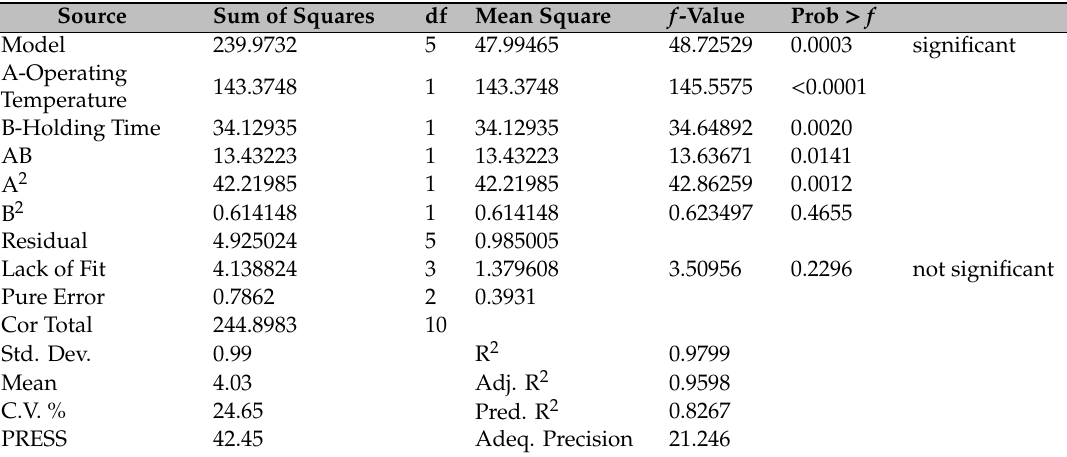
Table 9. ANOVA table for elongation to failure, ETF.